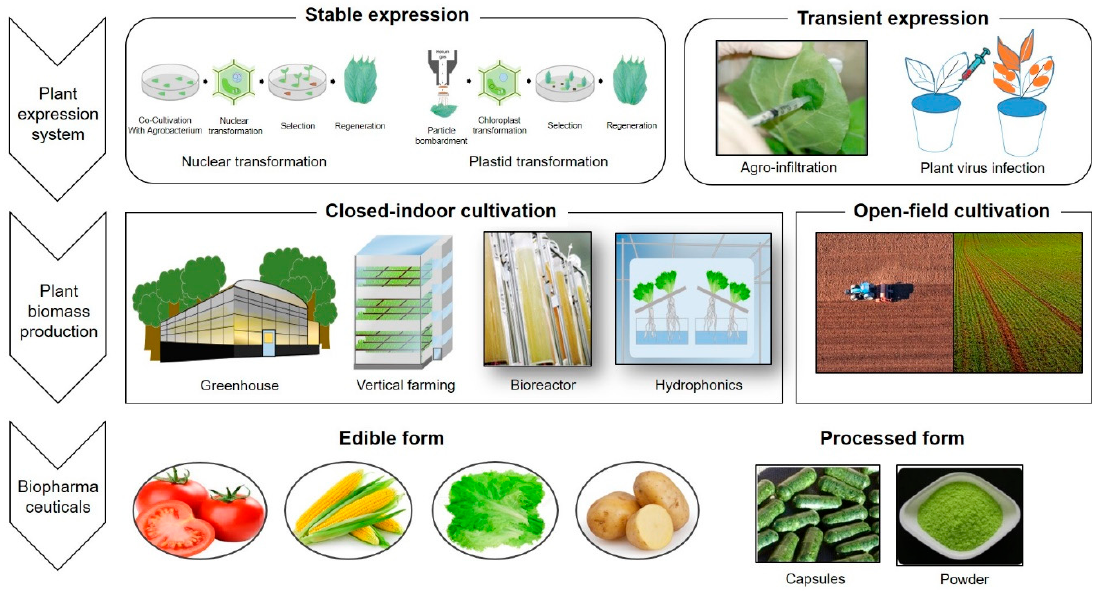
Figure 1. Overview of production system of plant-based biopharmaceuticals and plant biomass.